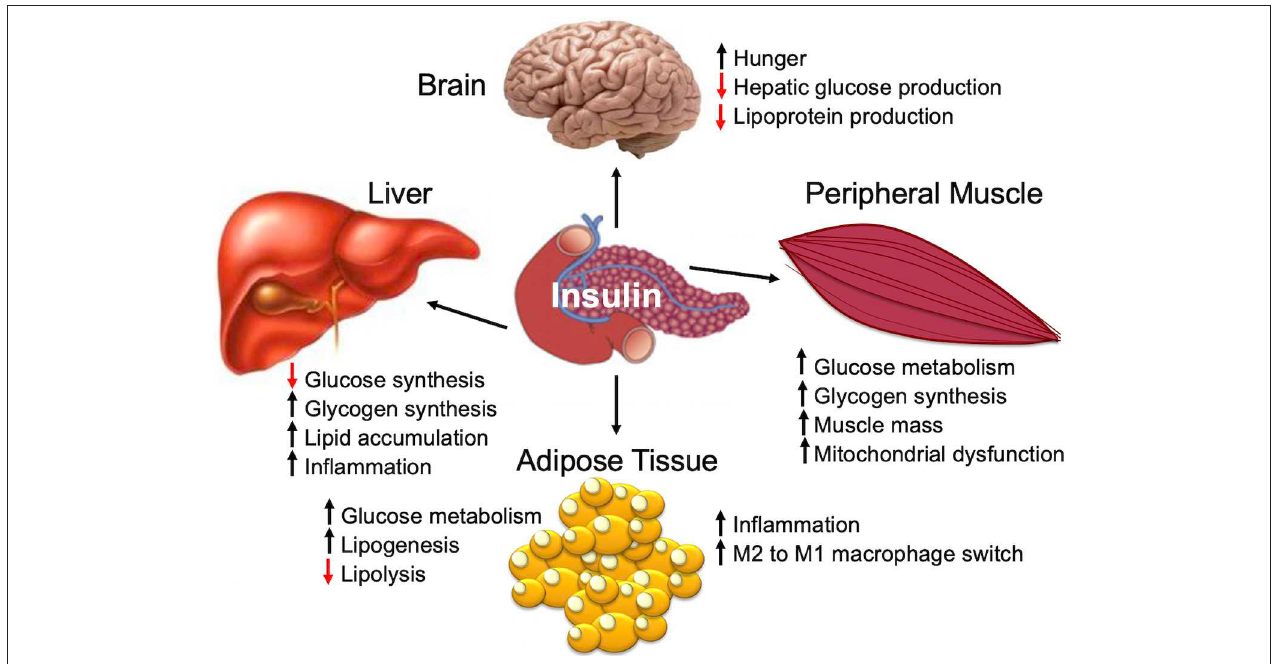
FIGURE 1 | Insulin is a major regulator of metabolism and organ